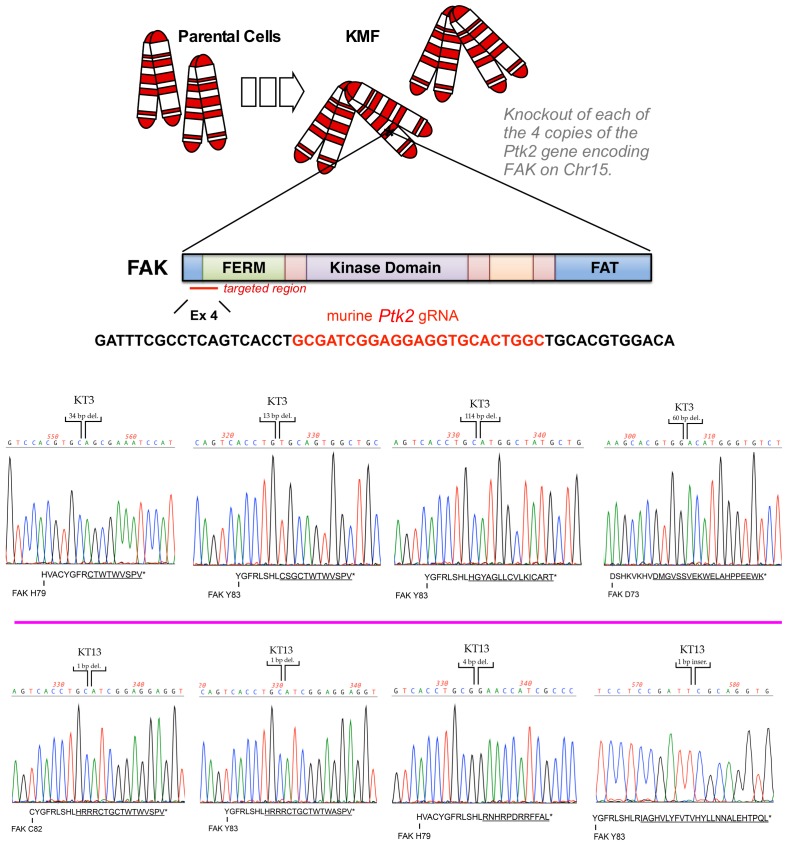
Sequencing validation of CRISPR/Cas9-mediated FAK KO in KMF cells.CRISPR/Cas9 gRNA guide (nucleotide sequence listed) was designed to target murine Ptk2 exon four which encodes amino acids within the FAK N-terminal FERM (4.1 ezrin radixin moesin) domain. PCR DNA amplification, TOPO-TA sticky end cloning, and Sanger sequencing of CRISPR-targeted region of exon four within FAK KO clones KT3 and KT13. Shown are sequencing chromatograms for four independent deletions in KT3 and four independent deletions or insertion within KT13 resulting in codon frame-shift and predicted FAK translational termination. Alternative reading frames are underlined with position of stop codon (*) denoted (Uniprot protein P34152).